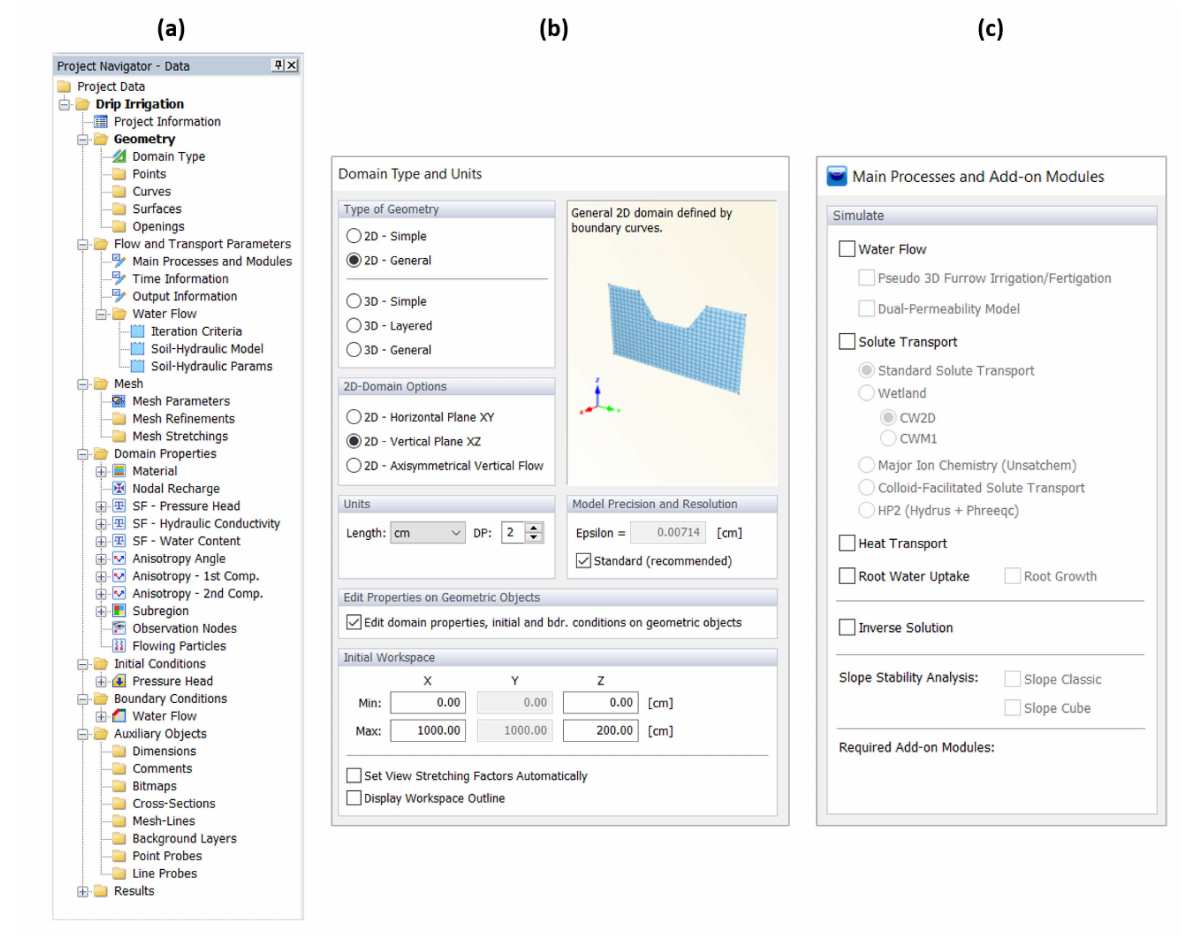
Figure 1. The Windows-based HYDRUS 2D/3D model software package. ( a ) Project navigator—data (interface), ( b ) domain types (2D/3D) and ( c ) main simulation